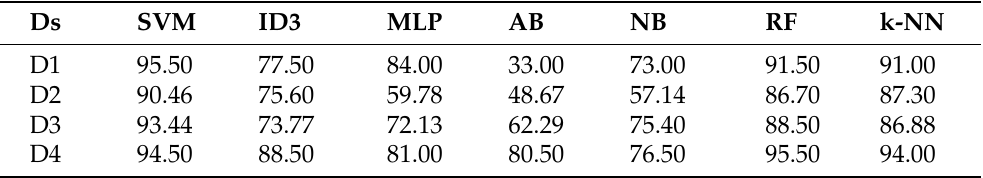
Table 6. Comparison of four datasets with state-of-the-art in terms of percentage accuracy in variants of proposed approach.